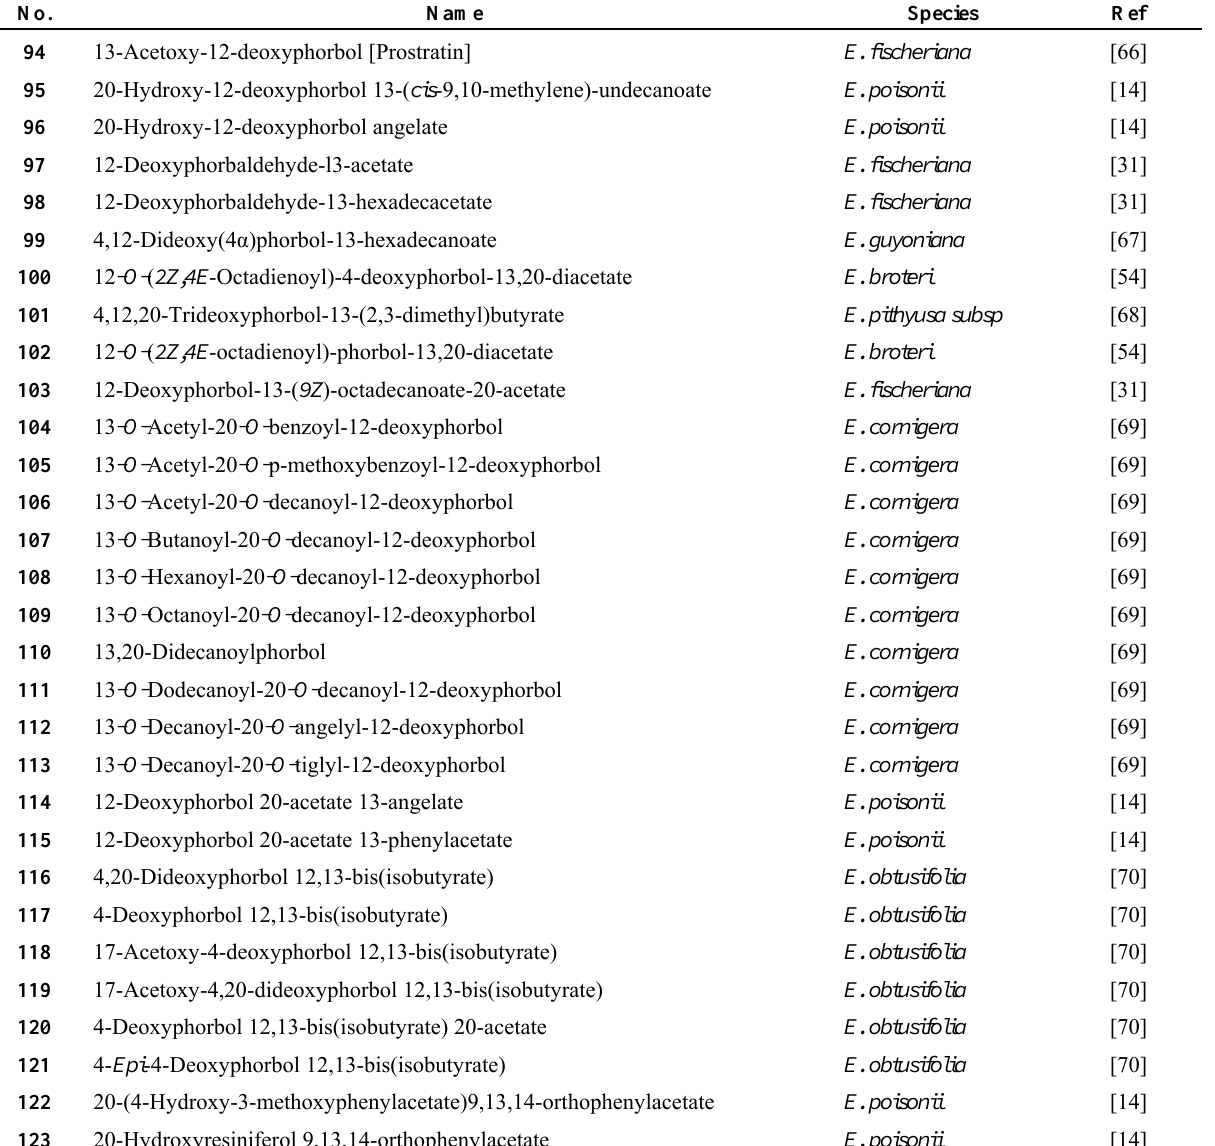
Table 3. Tigliane diterpenoids isolated from Euphorbia species.